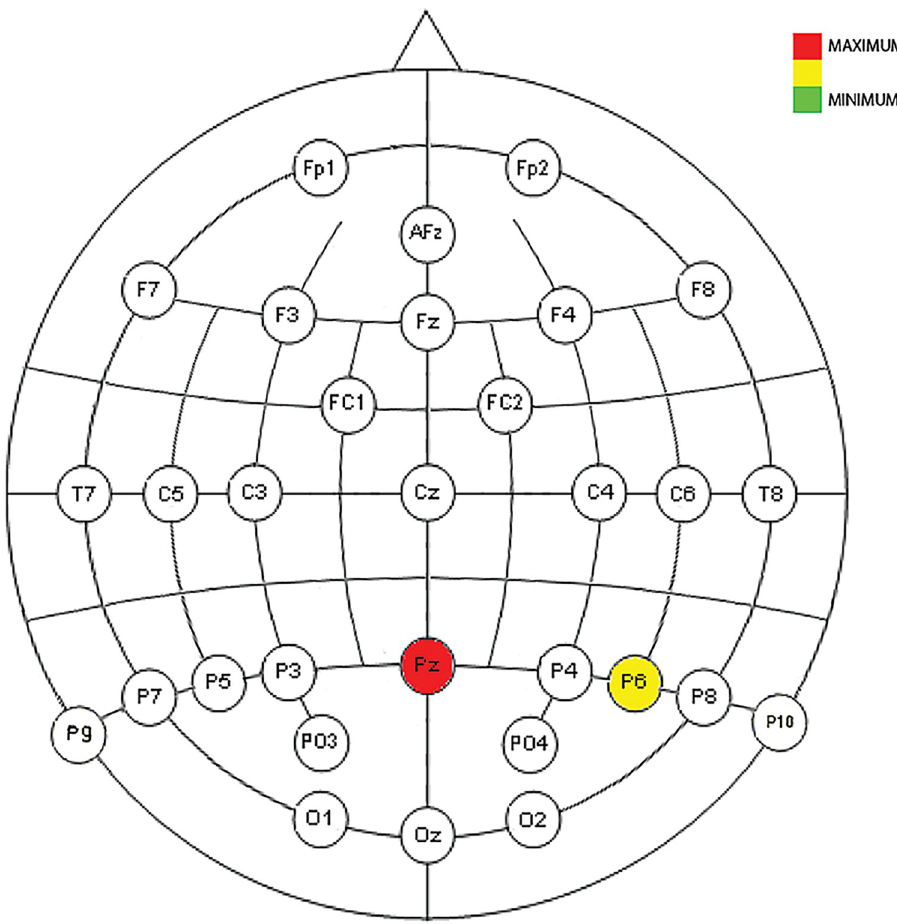
Fig 14. Neuronal distribution map of the electrodes that detect correlated, dependent, and significant monotonous slopes in the power change for all four ASFs in theta between -63 ms and 63 ms.